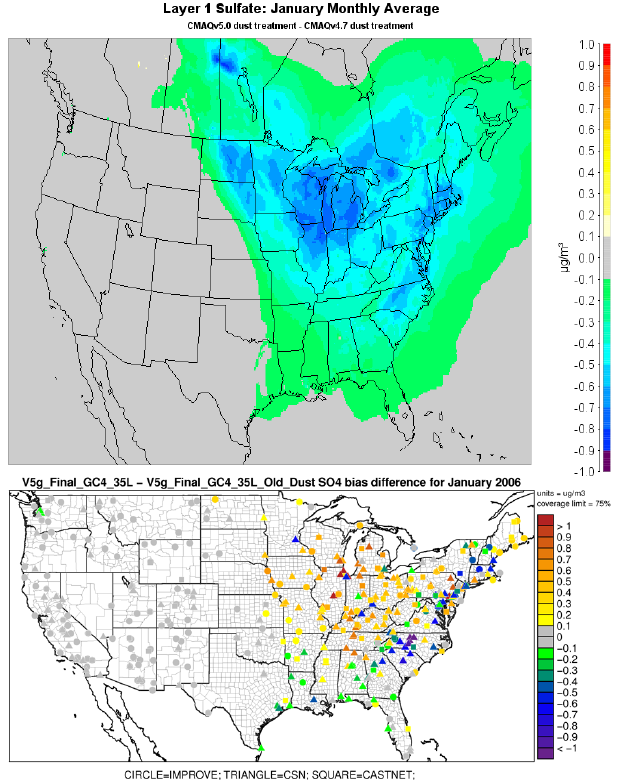
Fig. 5. (a) Difference in January monthly average SO 42 − concen- trations (µgm − 3 ) for the CMAQv5.0 base simulation and a CMAQ simulation with prescribed Fe and Mn values and the old rate con- stant. (b) Change in bias between the two CMAQ simulations at IM- PROVE (circles), CSN (triangles), and CASTNET (squares) sites. Warm colors indicate an increase in bias in the base simulation, while cool colors indicate a decrease in bias.